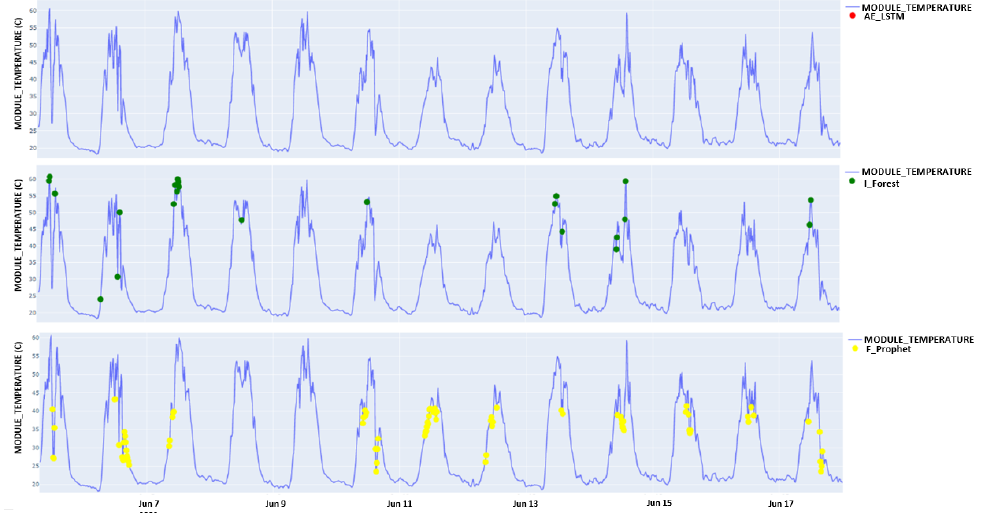
Figure 9. Anomaly detection outcomes from the three models on a healthy module temper- ature signal.